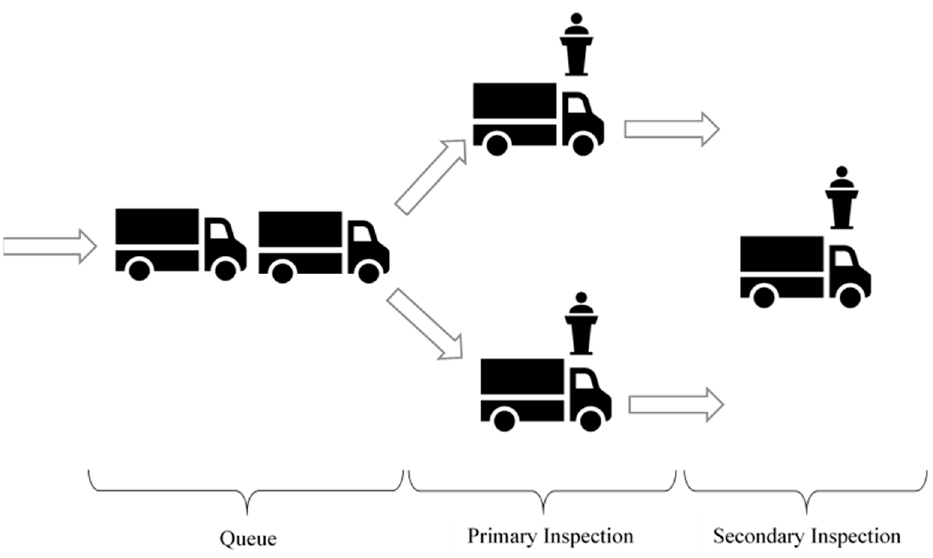
Figure 1 . Layout of POE with two primary and one secondary inspection lanes. Figure 1. Layout of POE with two primary and one secondary inspection lanes. A POE may be modeled as a queueing network, with each inspection officer as a server and one queue leading to the multiple servers. While the vehicles are queueing and waiting to be served, they are idling and releasing toxic gases into the